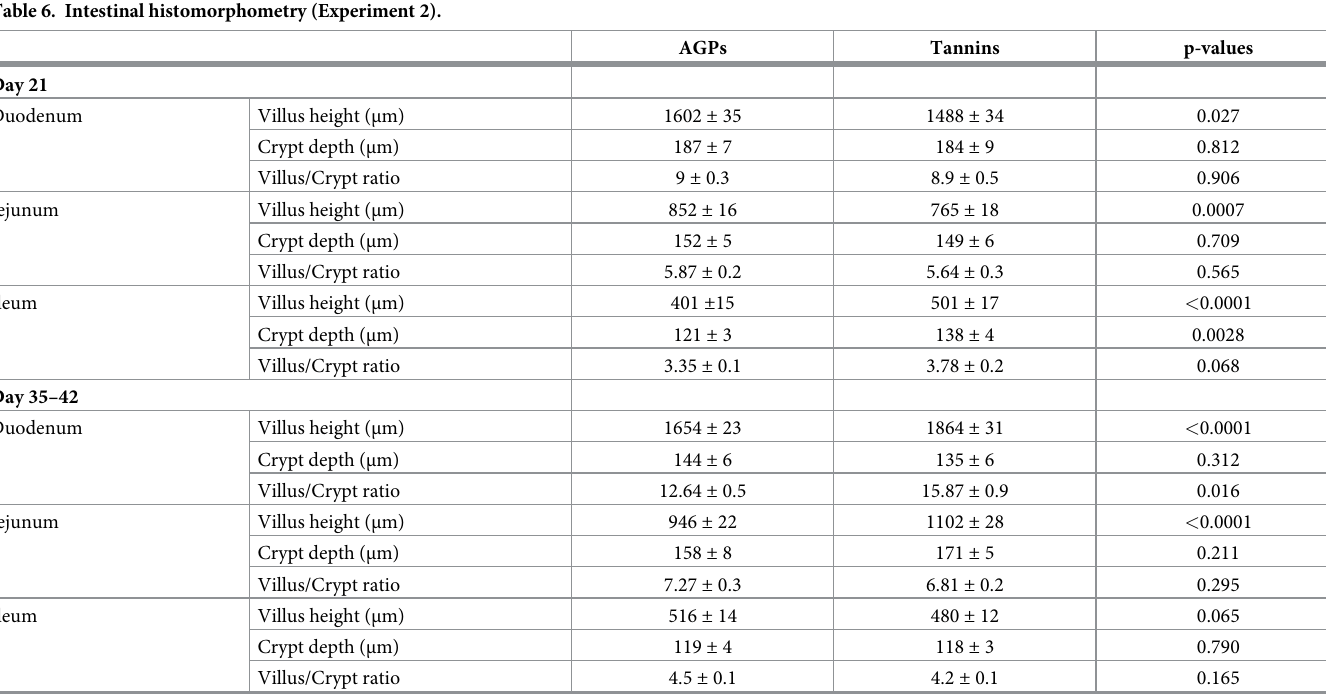
Table 6. Intestinal histomorphometry (Experiment